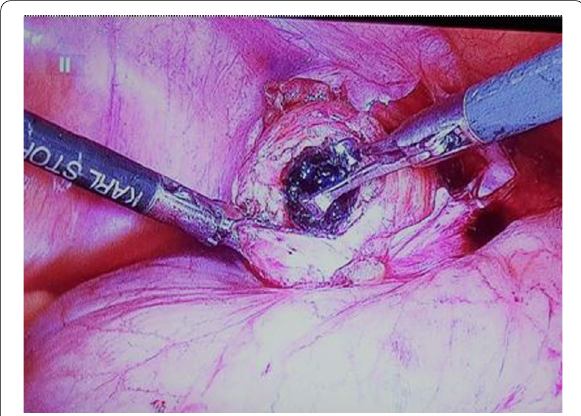
Fig. 2 Dissecting the posterior peritoneum